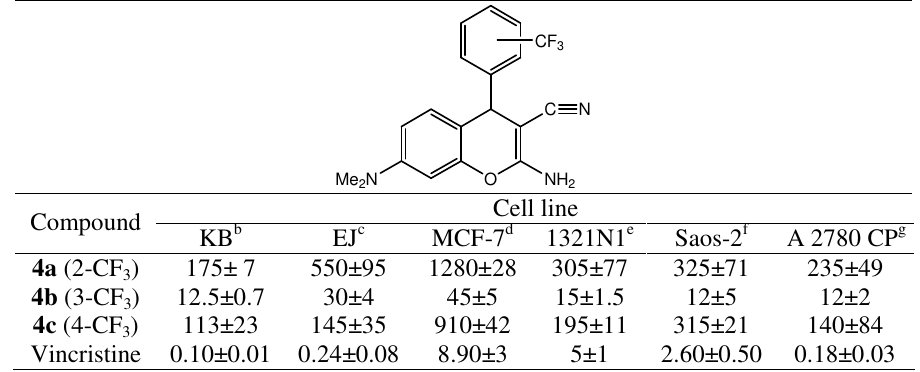
Table 1. Cytotoxic activity (IC comparison with